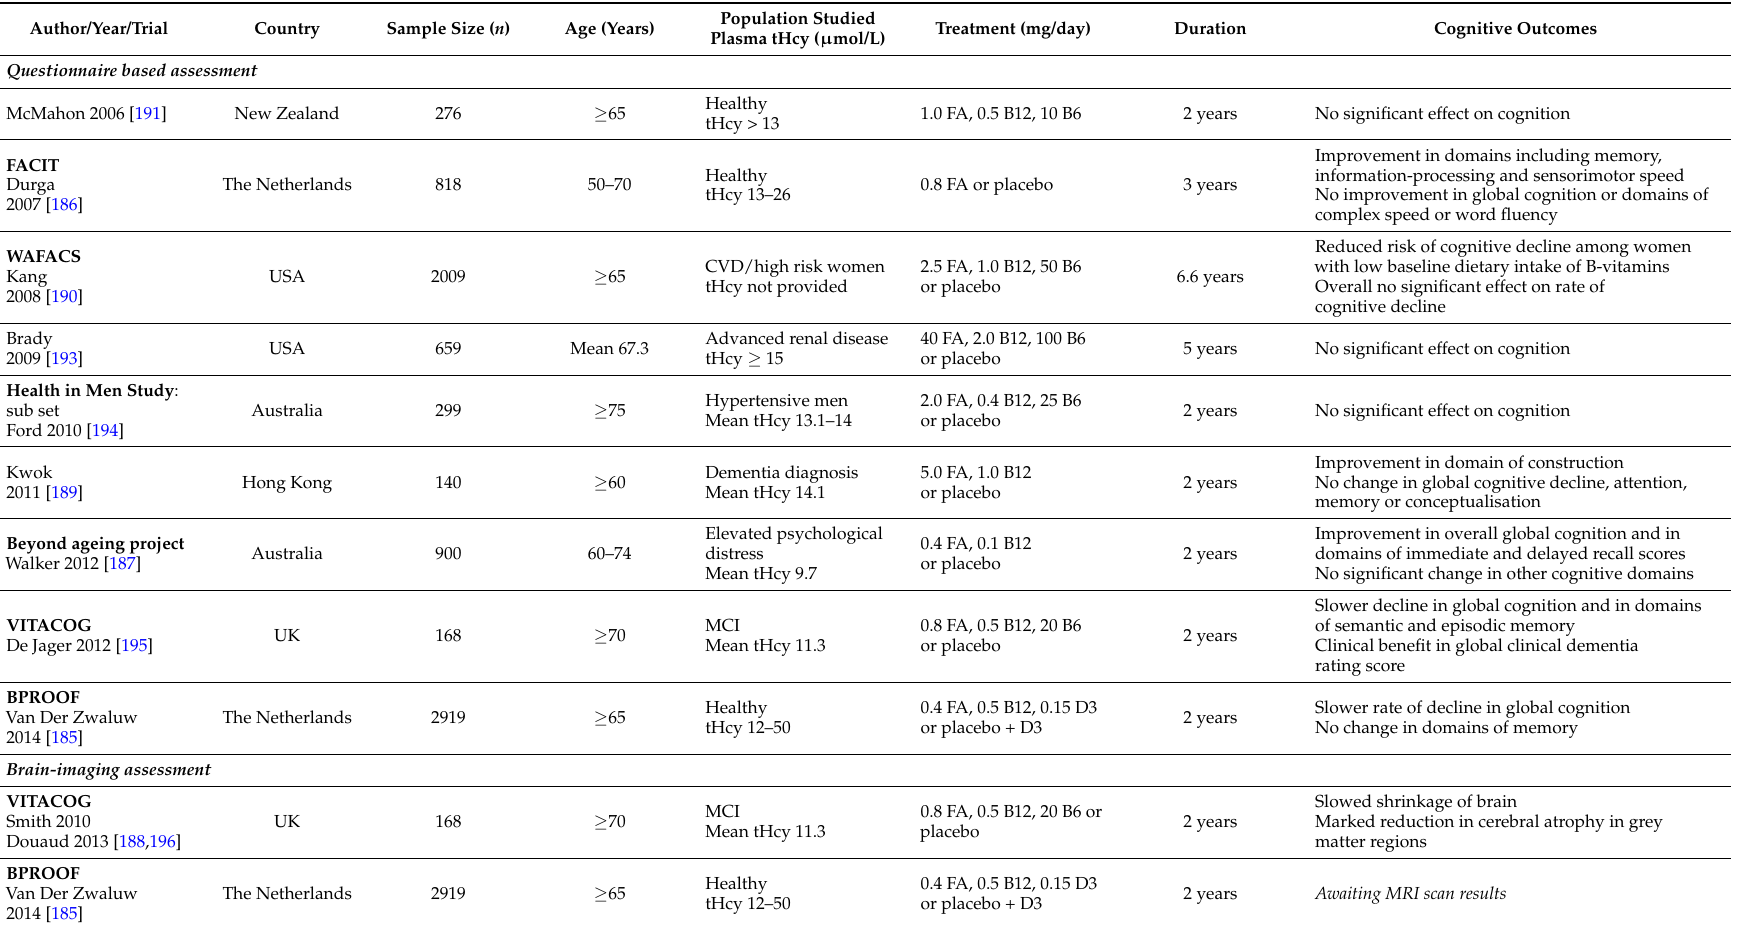
Table 4. Summary of Randomised Controlled Trials of 2 years or more assessing the effect of B vitamins on cognitive function in